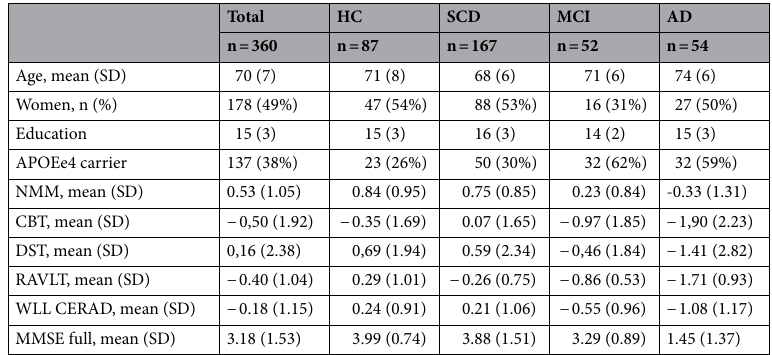
Table 1. Person characteristics and mean (SD) person ability measures (in logits) for the total sample of individual assessments and separated by the diagnostic groups.